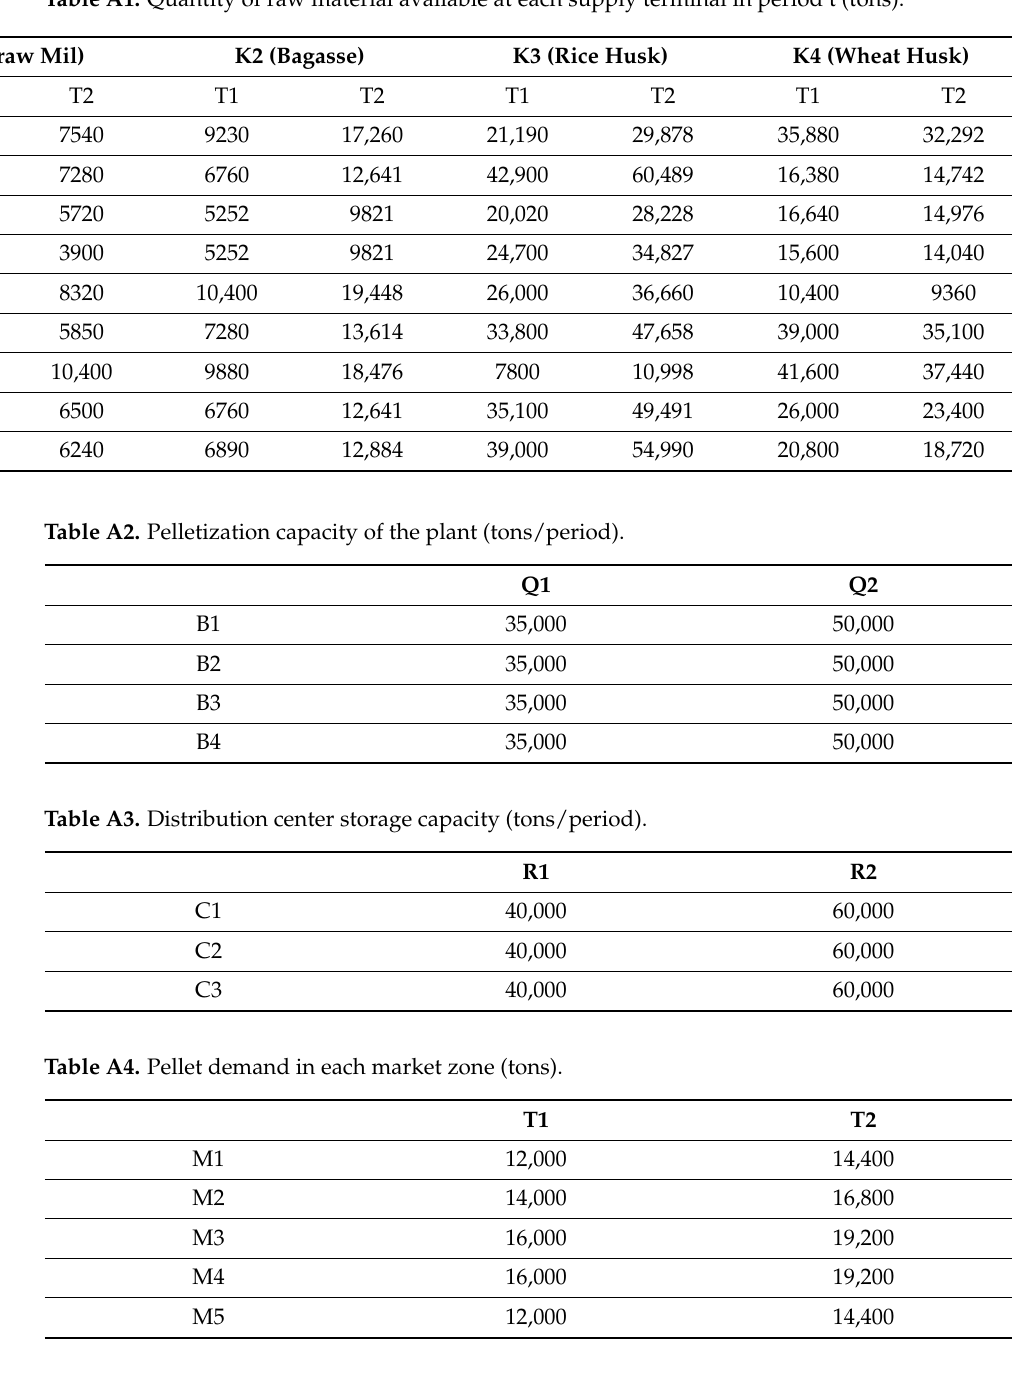
Table A1. Quantity of raw material available at each supply terminal in period t (tons).